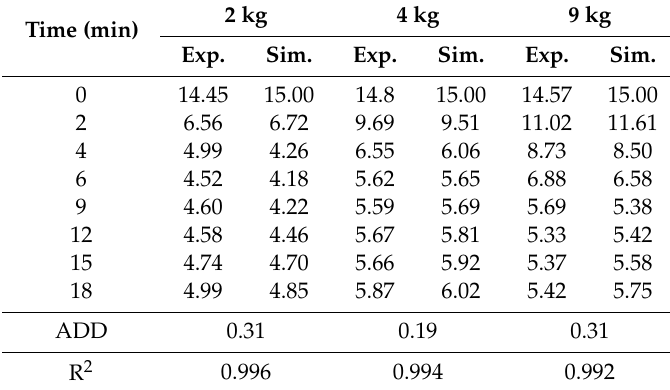
Table 3. The experimental (Exp.) and simulated (Sim.) moisture content (MC), absolute average deviation (AAD), and determination coe ffi cient (R 2 ) for the WG loading (2, 4, and 9 kg). 2 kg 4 kg 9 kg Time (min) Exp. Sim. Exp. Sim. Exp.